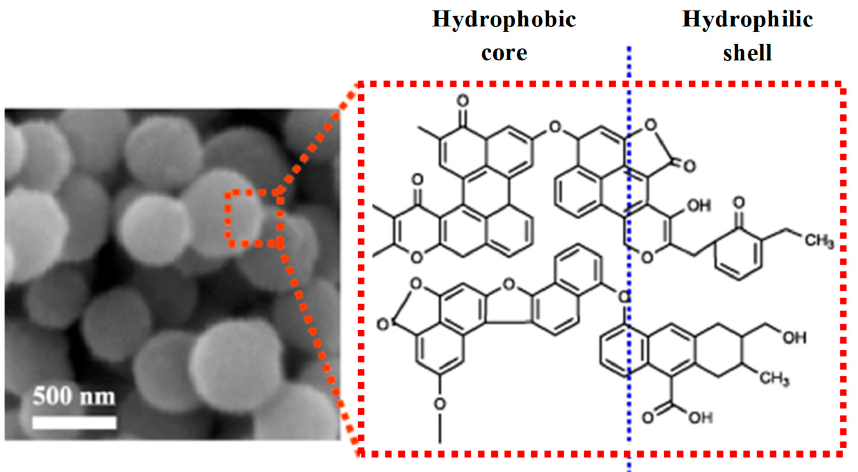
Figure 1. The microspheres core-shell structure of hydrochar. Reproduced from reference [61], Copyright (2009), with permission from John Wiley and Copyright (2009), with permission from John Wiley and Sons.